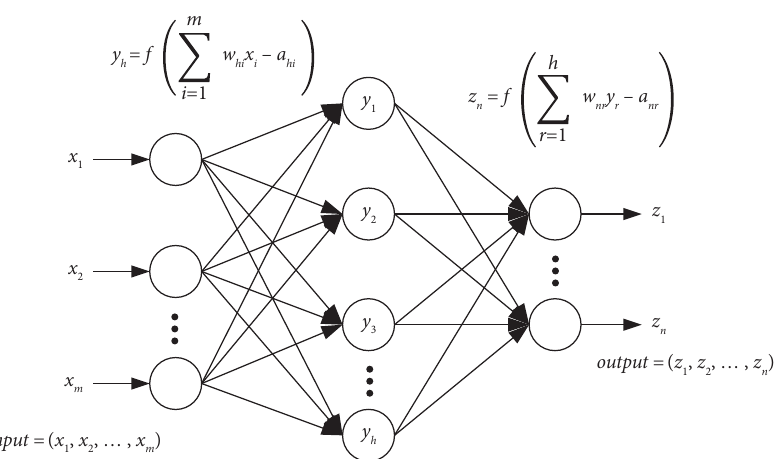
Figure 2: Structure of the backpropagation (BP) neural